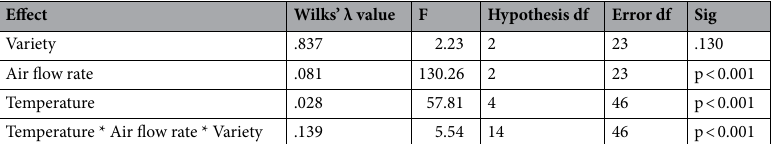
Table 4. Analysis of variance using GLM